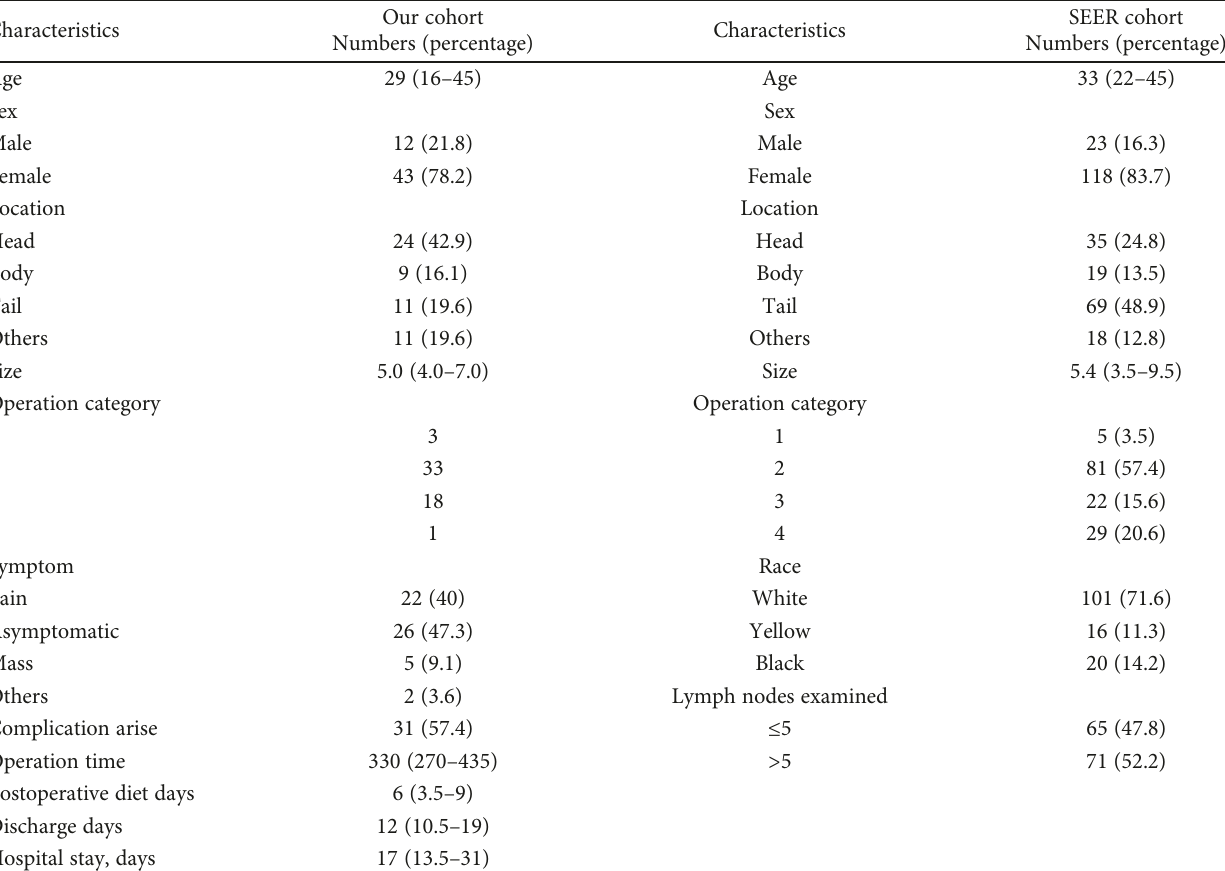
Table 1: Clinicopathological features of the SPN patients in our study.